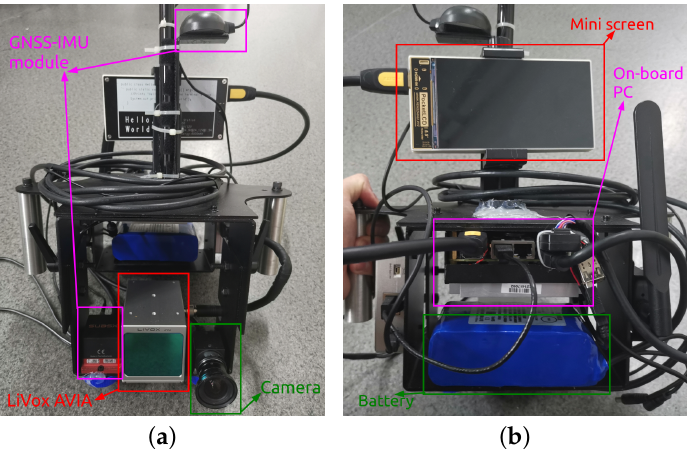
Figure 7. ( a ) The front view of our hardware. ( b ) The back view of our hardware. The total weight of our device is below 3